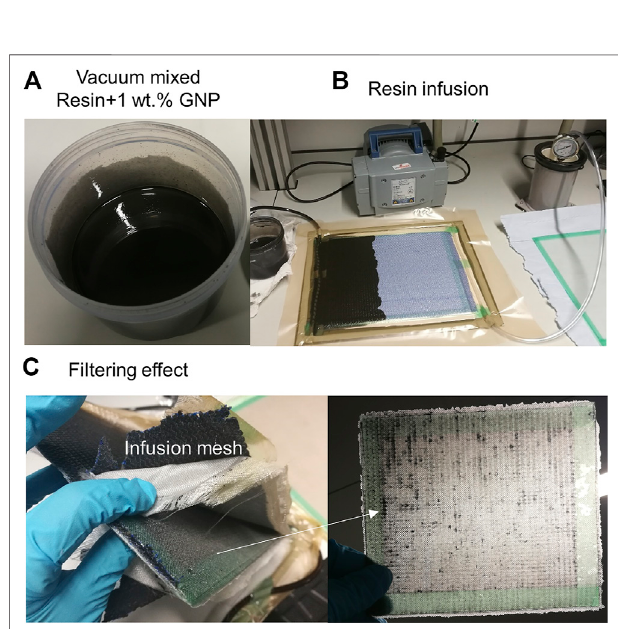
FIGURE 2 | (A) Vacuum mixed epoxy resin with 1 wt% GNP, (B) vacuum-assisted resin infusion procedure, and (C) cured panel with a large amount of GNPs fi ltered and left in infusion mesh, rather than penetrate into glass fi ber composites.